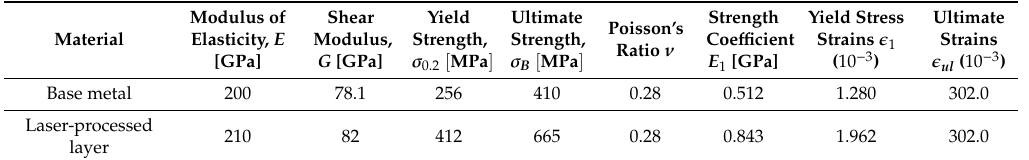
Table 7. Parameters of base metal and laser-processed layer used to simulate elastoplastic deformation of samples